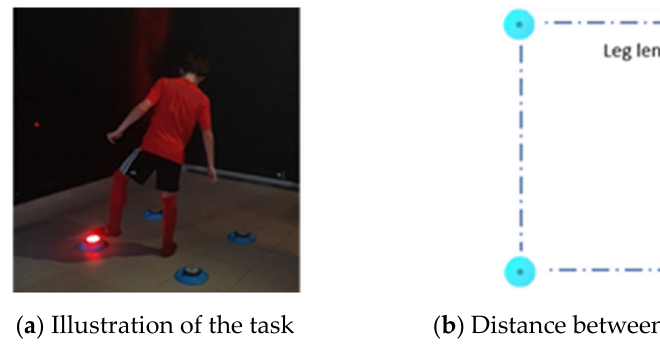
Figure 1. Representation of the OLBA.